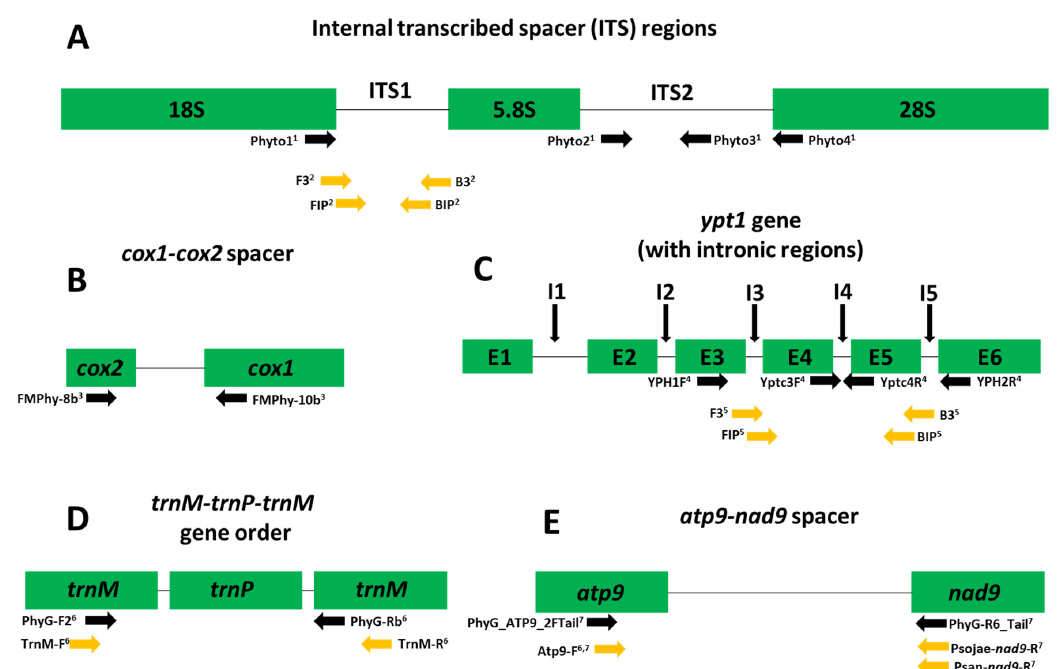
Figure 1. Visualization of intergenic regions used for diagnostic assays of oomycetes with particular emphasis on Phytophthora species. ( A ) Internal transcribed spacer region, ( B ) cox1 - cox2 spacer region, ( C ) ras -related ypt1 gene with intronic regions, ( D ) trnM-trnP-trnM gene order and ( E ) atp9 – nad9 spacer region. Also denoted are the primers used in various reported isothermal (yellow arrows) and non-isothermal (black arrows) assays for Phytophthora species. 1 Phytophthora ramorum -specific primers from Garbelotto et al., 2002. Phyto2 and Phyto3 are nested primers to be used after a preliminary amplification with Phyto1 and Phyto4. 2 Phytophthora ramorum -specific primers from Tomlinson et al., 2010. 3 Phytophthora genus-specific primers from Martin et al., 2004. 4 Phytophthora kernoviae -specific primers from Schena et al., 2006. Yptc3F and Yptc4R are nested primers to be used after a preliminary amplification with YPH1F and YPH2R. 5 Phytophthora infestans -specific primers from Khan et al., 2017. 6 Universal primers for Phytophthora species from Miles et al., 2015. Isothermal assay primers TrnM-F and TrnM-R are used for genus-specific detection. 7 Phytophthora genus-specific (PhyG_ATP9_2FTail and PhyG-R6_Tail, Atp9-F) and species-specific (Psojae-nad9-R for Phytophthora sojae and Psan-nad9-R for Phytophthora sansomeana ) primers from Rojas et al.,